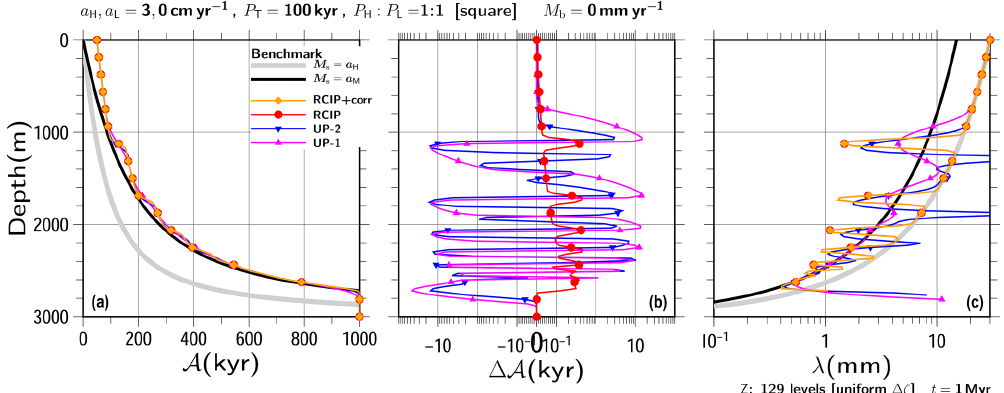
Figure 13. Same as Fig. 7 but for the results of transient experiments conducted using a square-wave surface mass balance with a L = 0cmyr − 1